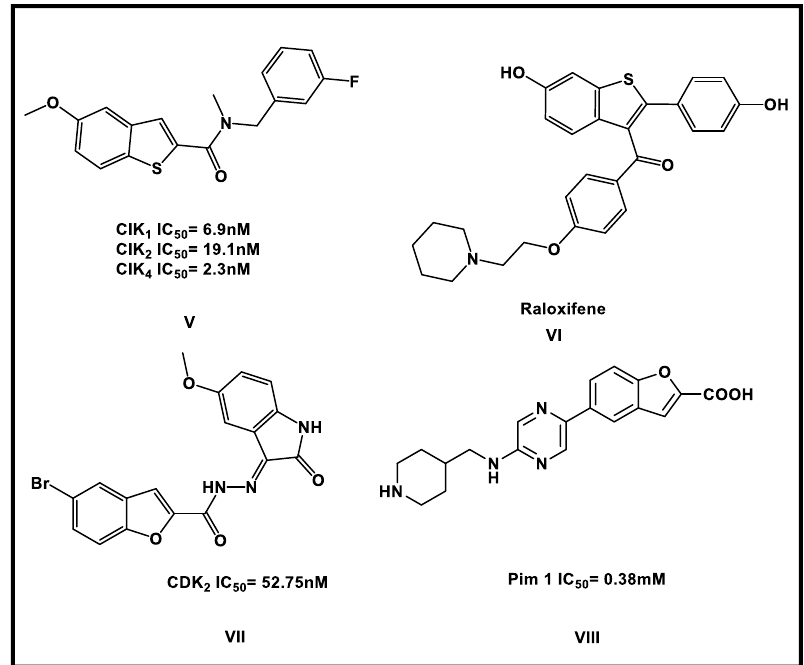
Figure 2. Reported benzothiophenes as CIK1,2,4 inhibitors (V), raloxifene (VI): anti-breast cancer, benzofuran derivatives VII and VIII as CDK2 and Pim1 inhibitors, respectively.